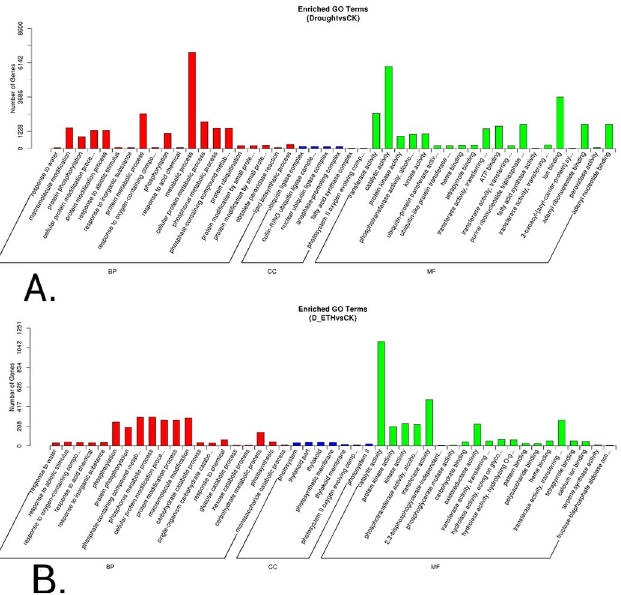
Fig 7. Enriched GO terms. A. Drought vs CK; B. ETH_D vs CK. ‘CK’ means well-watered control plants without ethephon pre-treatment. ‘Drought’ means drought-stressed plants without ethephon application. ‘ETH_D’ means drought-stressed plants with ethephon pre-treatment.